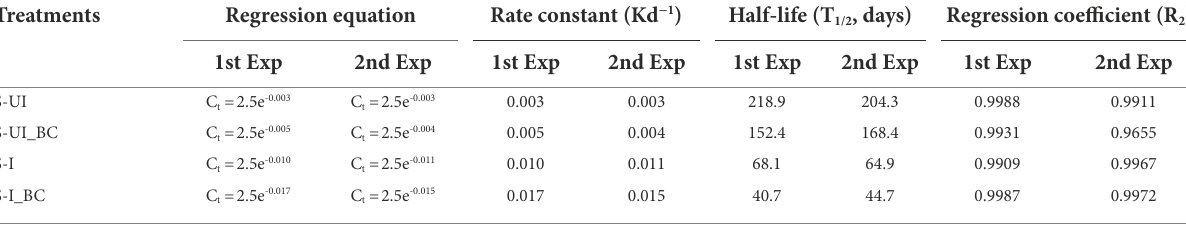
TABLE 2 Metribuzin (MB) degradation kinetics in soil under various treatments. Treatments